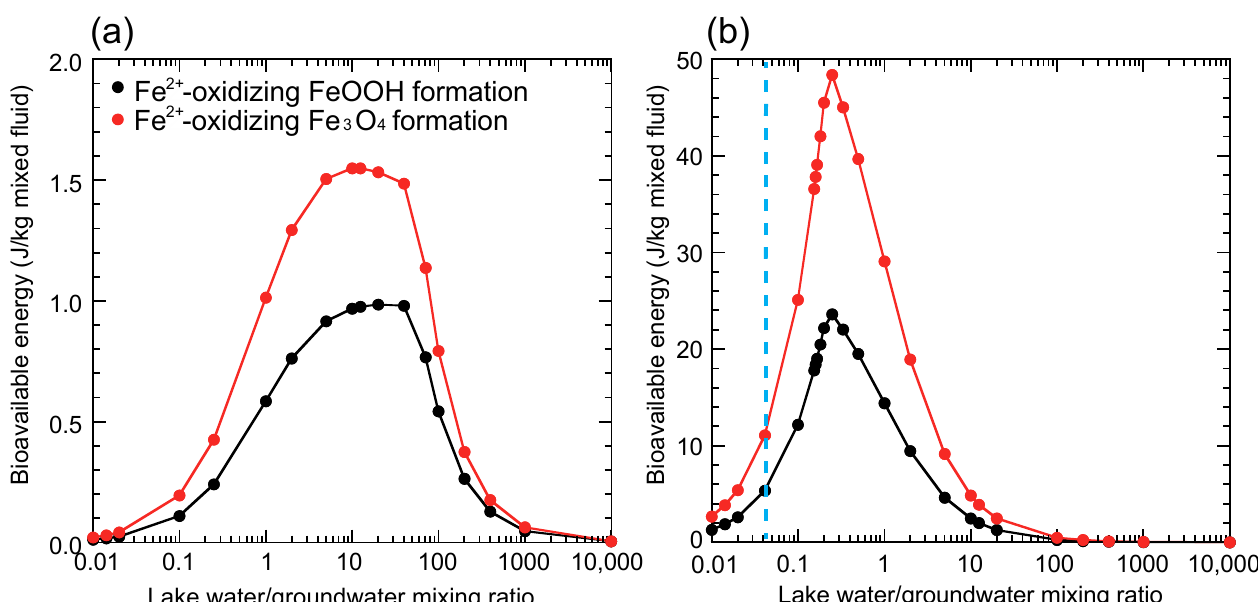
Figure 7. Bioavailable energy (J/kg mixed fluid) from aerobic Fe 2+ -oxidizing goethite and magnetite formation as a function of surface water and groundwater water mixing ratio ( a ) on Mars and ( b ) on Earth (Budo-pond, Hiroshima, Japan). The blue dotted line in ( b ) highlights the fluid mixing zone actually inhabited by aerobic Fe 2+ -oxidizing microbes.